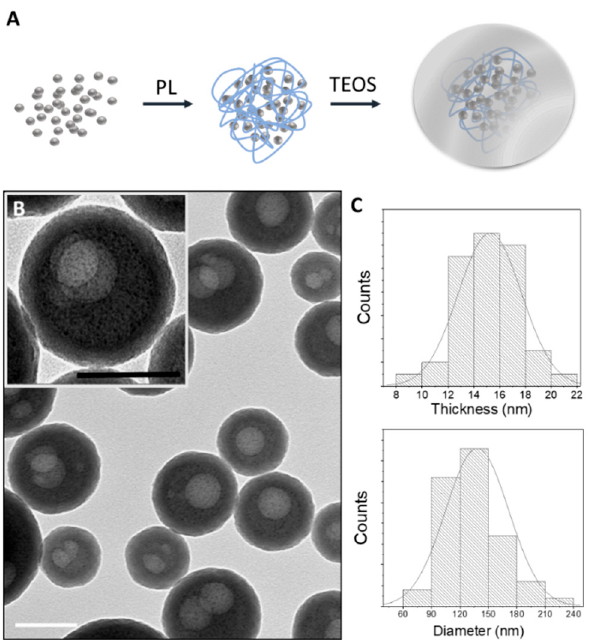
Figure 1. ( A ) General scheme of the formation of AgNAs. Silver nanoparticles and poly( L -lysine) (PL) self-arrange in controlled aggregates. Silica shells were grown on their surface due to hydrolysis of tetraethyl orthosilicate. ( B ) A wide-area TEM image of an AgNAs sample with a zoom in the inset. Scale bars: 100 nm. ( C ) Thickness distribution of shells (upper) and size distribution of NAs (bottom) plotted based on at least 100 particles imaged by